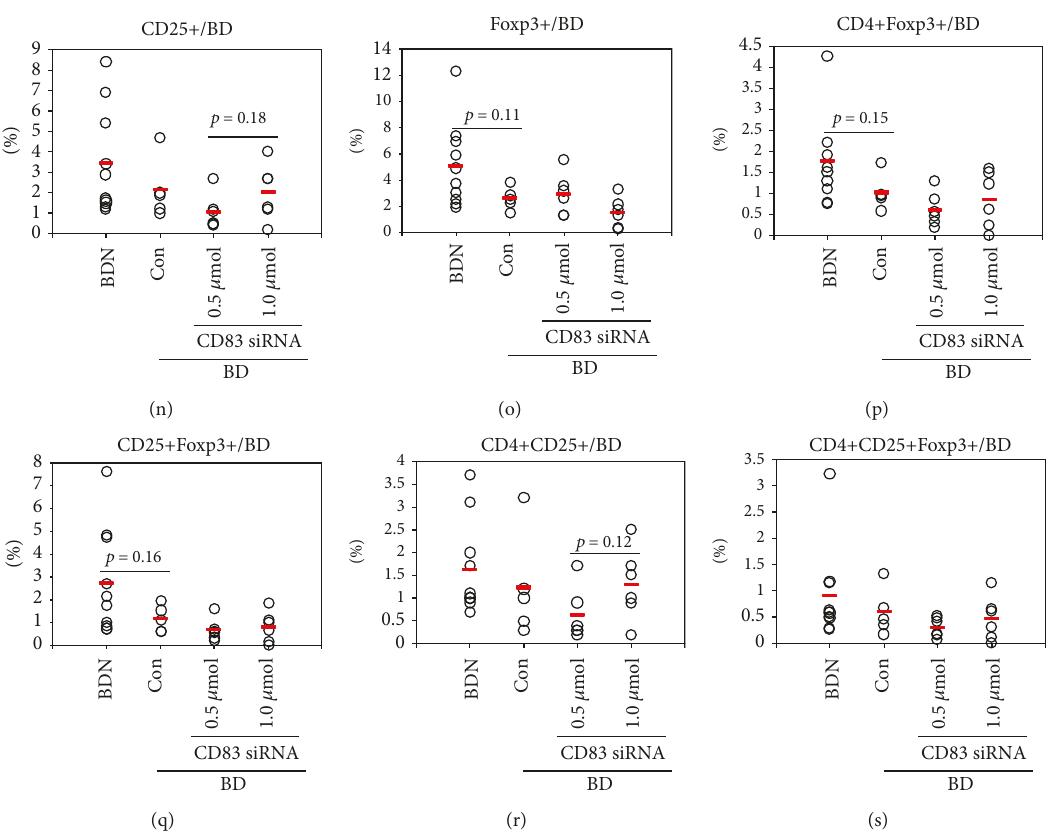
Figure 3: CD83 siRNA decreases the frequencies of CD83+ cells in normal mice. (a – d) Frequencies of CD40, CD83, CD80, and CD86 in the surface of peripheral blood leukocytes (PBL) and in the peritoneal macrophages of normal mice treated with CD83 siRNA were evaluated by FACS analysis ( n = 5 in each group). (e – h) CD83 siRNA decreases frequencies of CD83 in BD mice. Frequencies of CD40, CD83, CD80, and CD86 in the surface of peripheral blood leukocytes (PBL) and in the peritoneal macrophage of BD mice treated with CD83 siRNA were evaluated by fl ow cytometry analysis. n = 4 , BD symptomatic mice were used in control groups as scramble siRNA; n = 6 , BD symptomatic mice were used in the 0.5 μ mol and 1.0 μ mol CD83 siRNA-treated groups. (i, j) CD83 siRNA treatment signi fi cantly decreased the severity score of BD mice and improved symptoms. (k) Treatment schedule of CD83 siRNA to BD mice. (l) Representative histogram of CD83+ cell frequencies in PBL and peritoneal macrophage of BD mice treated with CD83 siRNA. (m – s) Regulatory T cells in BD mice analyzed by FACS analysis. Frequencies of CD4+, CD4+Foxp3+, CD4+CD25+, and CD4+CD25+Foxp3+ regulatory T cells in BDN ( n = 10 ), BD ( n = 5 ), jetPEI-treated BD ( n = 6 ), and CD83 siRNA-treated BD mice ( n = 6 ) were evaluated by FACS analysis. n indicates the number of mice used in each group. The p value was determined by Student ’ s t -test. Experiments were performed more than three independent PBL (Figure 3(h)). Frequencies of CD80+ cells in PBL in the 0.5 μ mol ( 71 15 ± 8 23 % vs. 84 1 ± 5 29 % , p = 0 02 ) and in